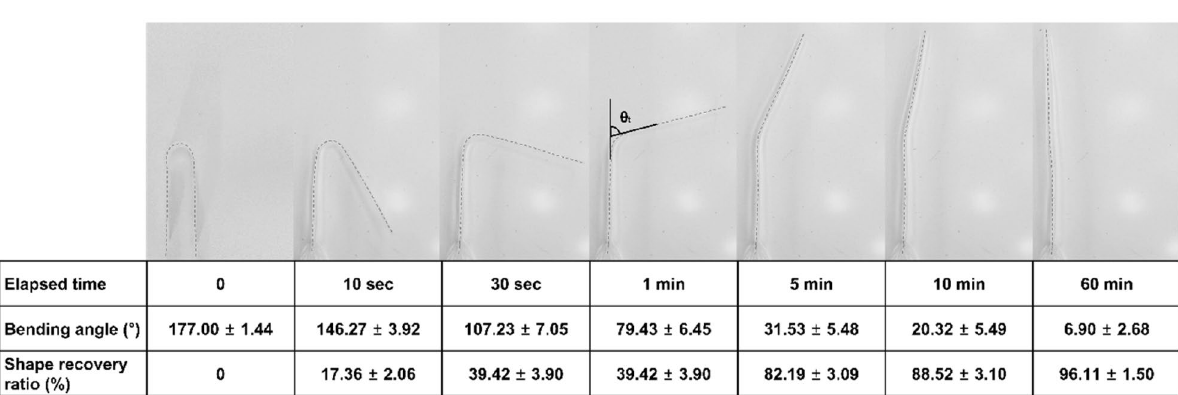
Figure 3. DMA temperature sweep; ( a ) storage and loss modulus of TC-85; ( b ) storage and loss modulus of PETG; ( c ) loss tangent of TC-85; ( d ) loss tangent of PETG.